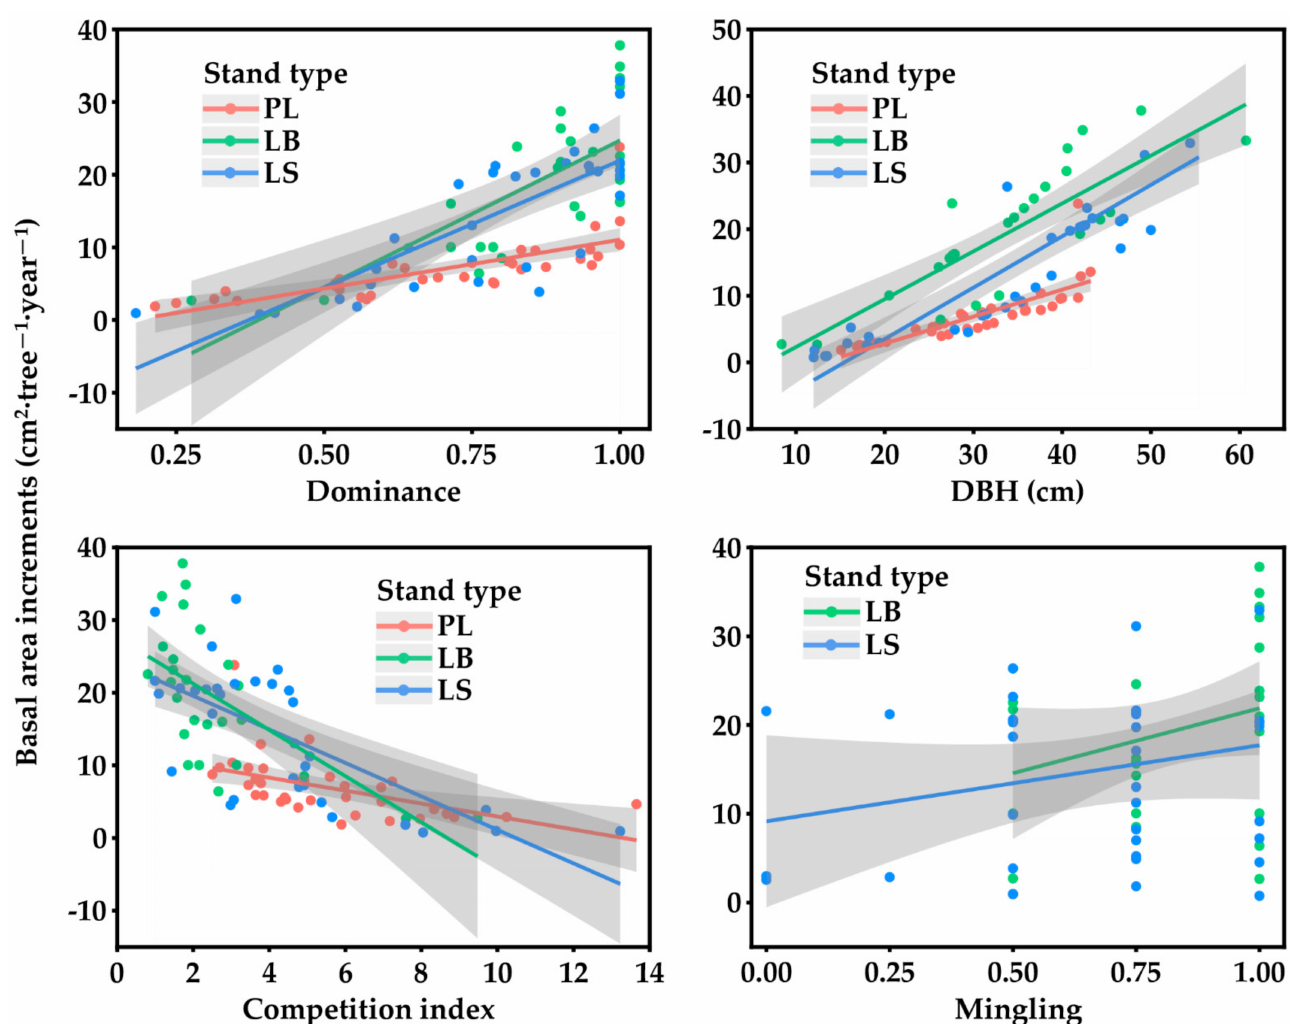
Figure 2. Individual basal area increments in different larch stand types varied with dominance, DBH, competition index, and mingling. Grey areas represent 95% confidence interval for each stand type. Table 3. Parameter estimations of the linear mixed model of the individual basal area increments